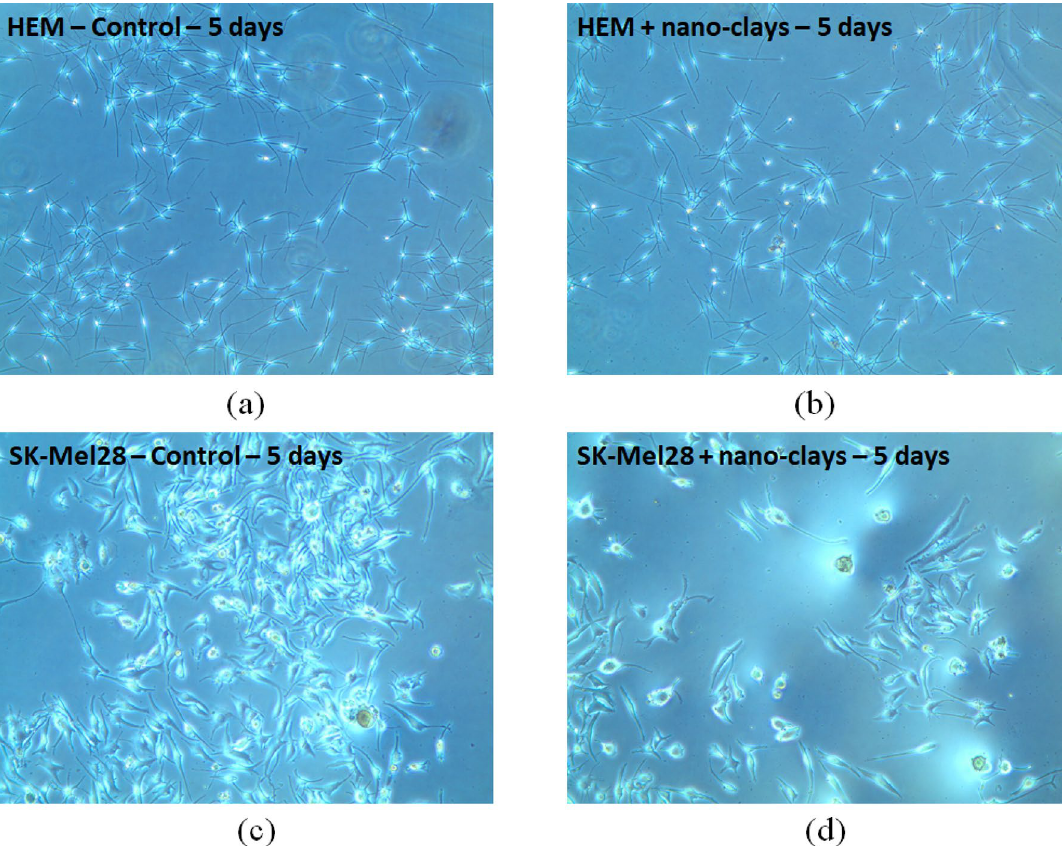
Figure 2. Viability of melanoma and melanocytes cells using nano-clays ( a ) and ( b ) respectively control and 5-days after nano-clay treatment of melanocyte (HEM) cells, ( c ) and ( d ) respectively control and 5-days after nano-clay treatment of melanoma cells (SK-Mel-28). The cells were treated with PFl-1 and SWy-3 mix (25:75) at concentrations of 0 (control) and 10 μg/ml for 5 days. The numbers of viable cells were counted at day 5 post-